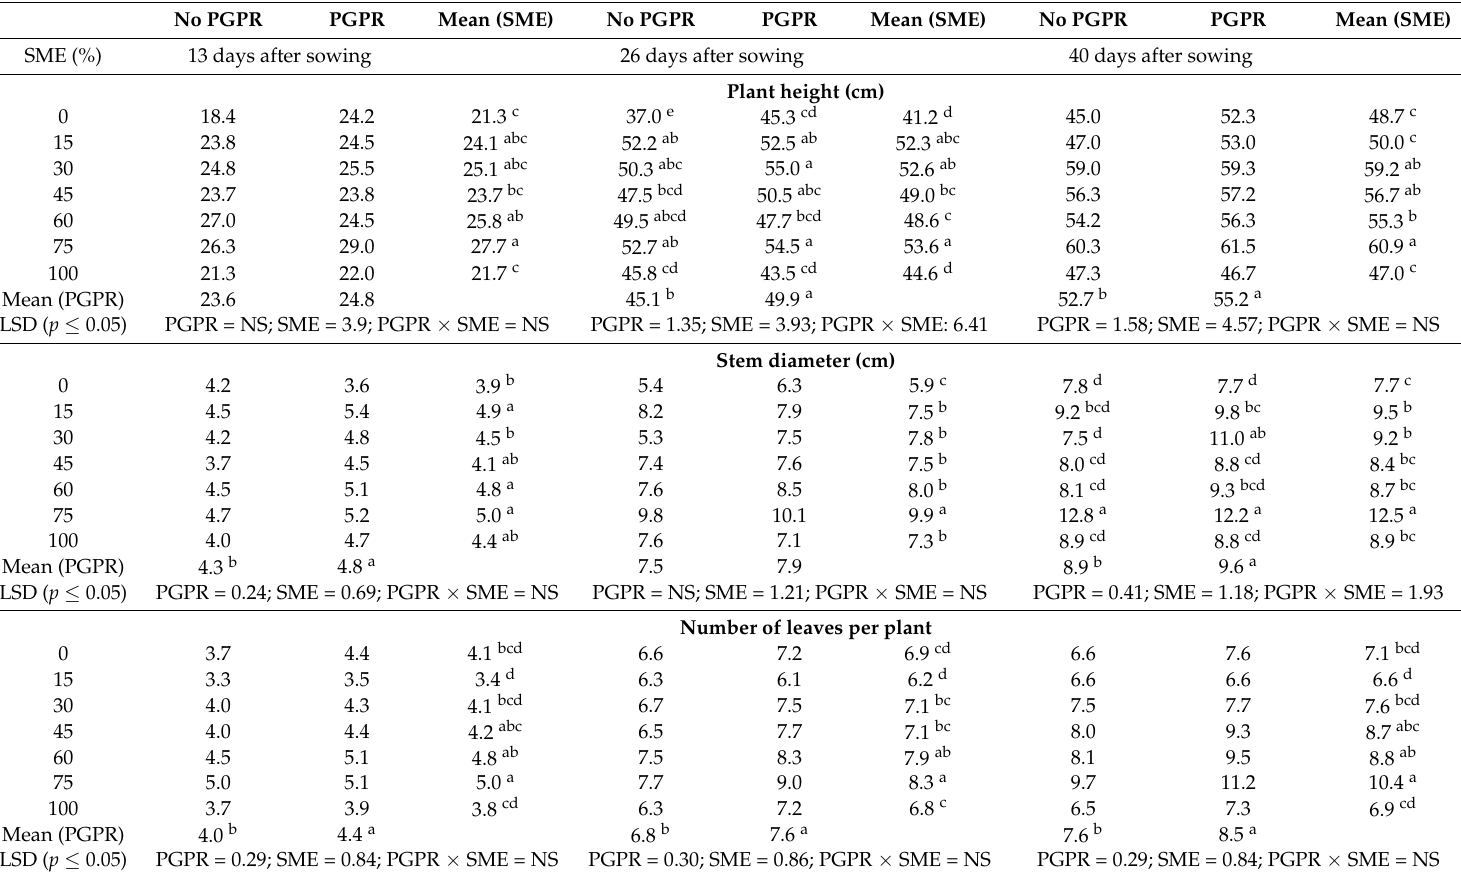
Table 1. Influence of diluted sugar mill effluent and PGPR on plant height, stem diameter and number of leaves per